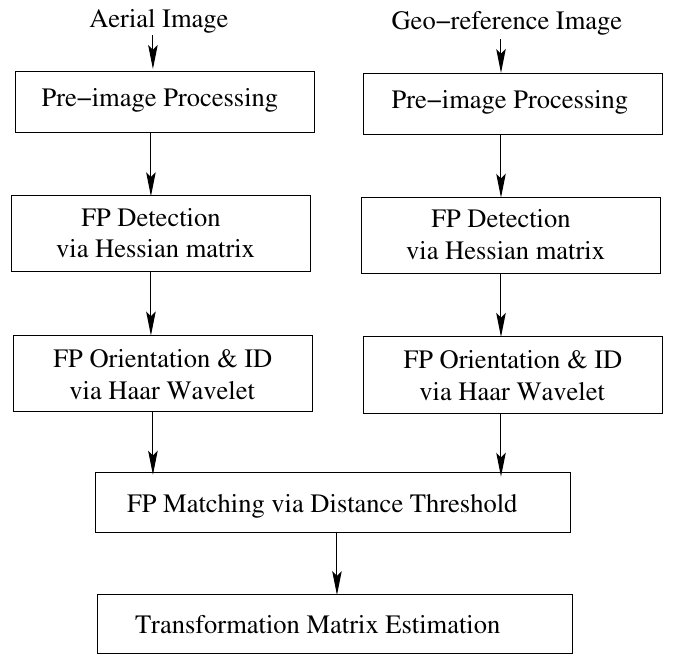
Figure 2. Flowchart of the implemented speeded-up-robust-features (SURF)-based algorithm. The algorithm outputs estimated transformation matrix by solving (2) using feature point pairs if more than four matched feature points (FP) between image pair are